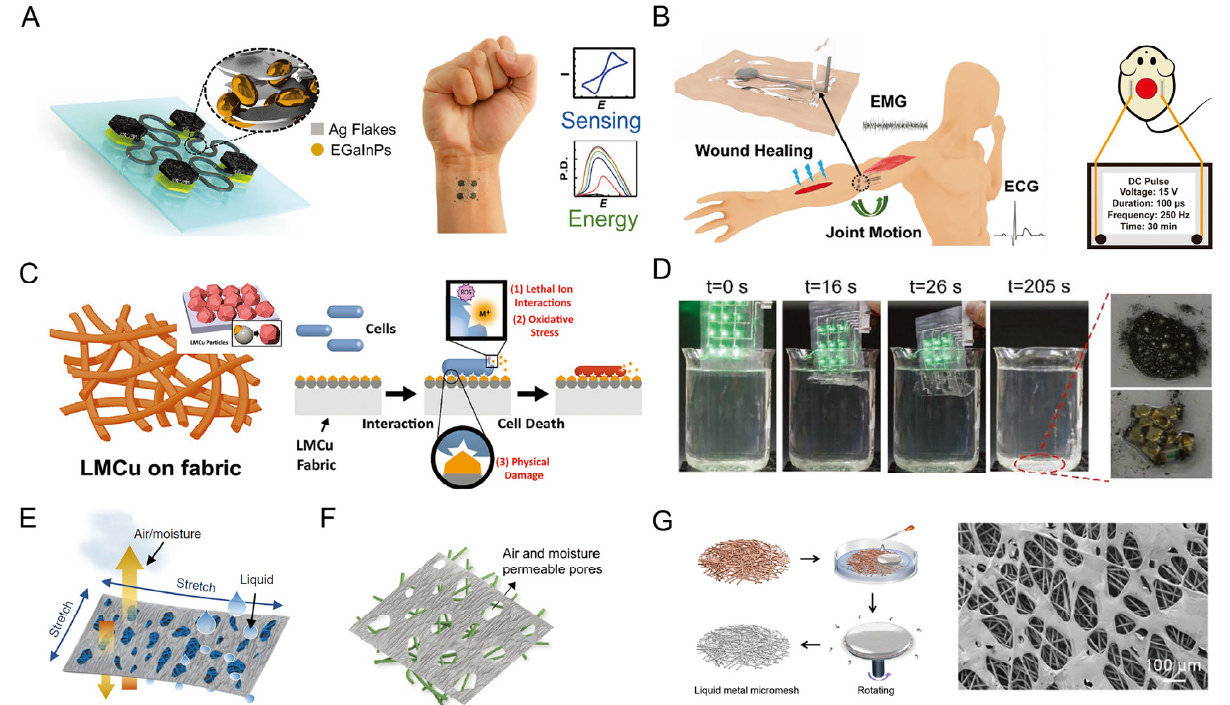
Figure 14. The LM-based electronics for other biomedical and sustainable applications. ( A ) Schematic of the LM island–bridge structure for wearable electrochemical devices ( left ), and the photograph of this device for on-skin sensing and energy applications [117]. Copyright: (2020) WILEY-VCH. ( B ) Schematic illustration of LM-based adhesive composite in the applications of wound healing, ECG, and joint motion monitoring ( left ), and the wound healing experiments on the back of mice with pulse electrical stimulation ( right ) [118]. Copyright: (2020) WILEY-VCH. ( C ) Schematic of LM–copper coating on a fabric ( left , inset: the LMCu patterns on the fabric) and the proposed antimicrobial mechanism of LMCu coated on the fabric [119]. Copyright: (2021) WILEY-VCH. ( D ) Photographs of the recycling process for LM-based LED array [121]. Copyright (2019) WILEY-VCH. ( E ) Schematic illustration of the LM fiber mat via pre-stretching processing [57]. Copyright: (2021) Springer Nature. ( F ) Schematic illustration of porous LM super-lyophilic scaffold via pre-stretching [122]. Copyright: (2021) WILEY-VCH. ( G ) The fabrication of intrinsic highly permeable LM micromesh [123]. Copyright: (2022) American Chemical Society.